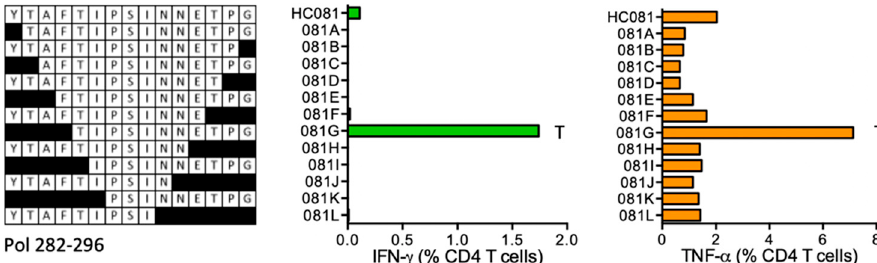
Figure 7. HC081/VID 415—definition of CD4 + T-cell epitopes in HIV-1 protein Pol. HC081 expanded PBMC from vaccine recipient 415 were tested in an ICS assay against serially truncated peptides and CD4 + T cells producing the IFN- γ (green) and TNF- α (orange) cytokines were enumerated using flow cytometry. Amino acid T indicates the stimulatory peptide terminus.